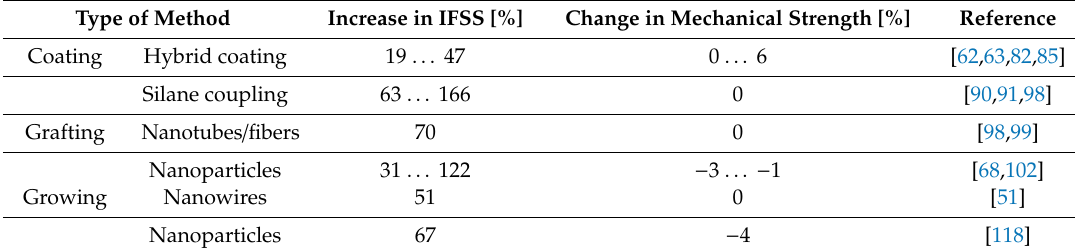
Table 1. Concise summary of the surface treatment types discussed in this